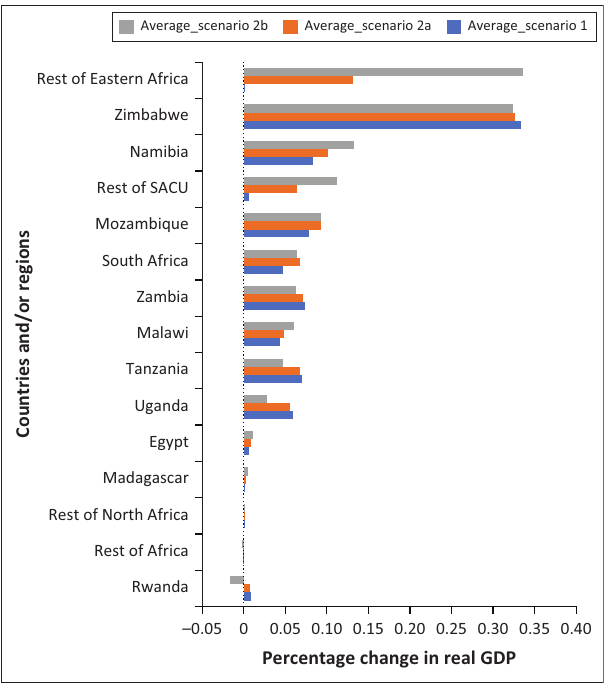
FIGURE 3: Projected cumulative average percentage changes in real GDP in countries/regions other than the top 5: 2019‒2024 (ranked according to Scenario 2b